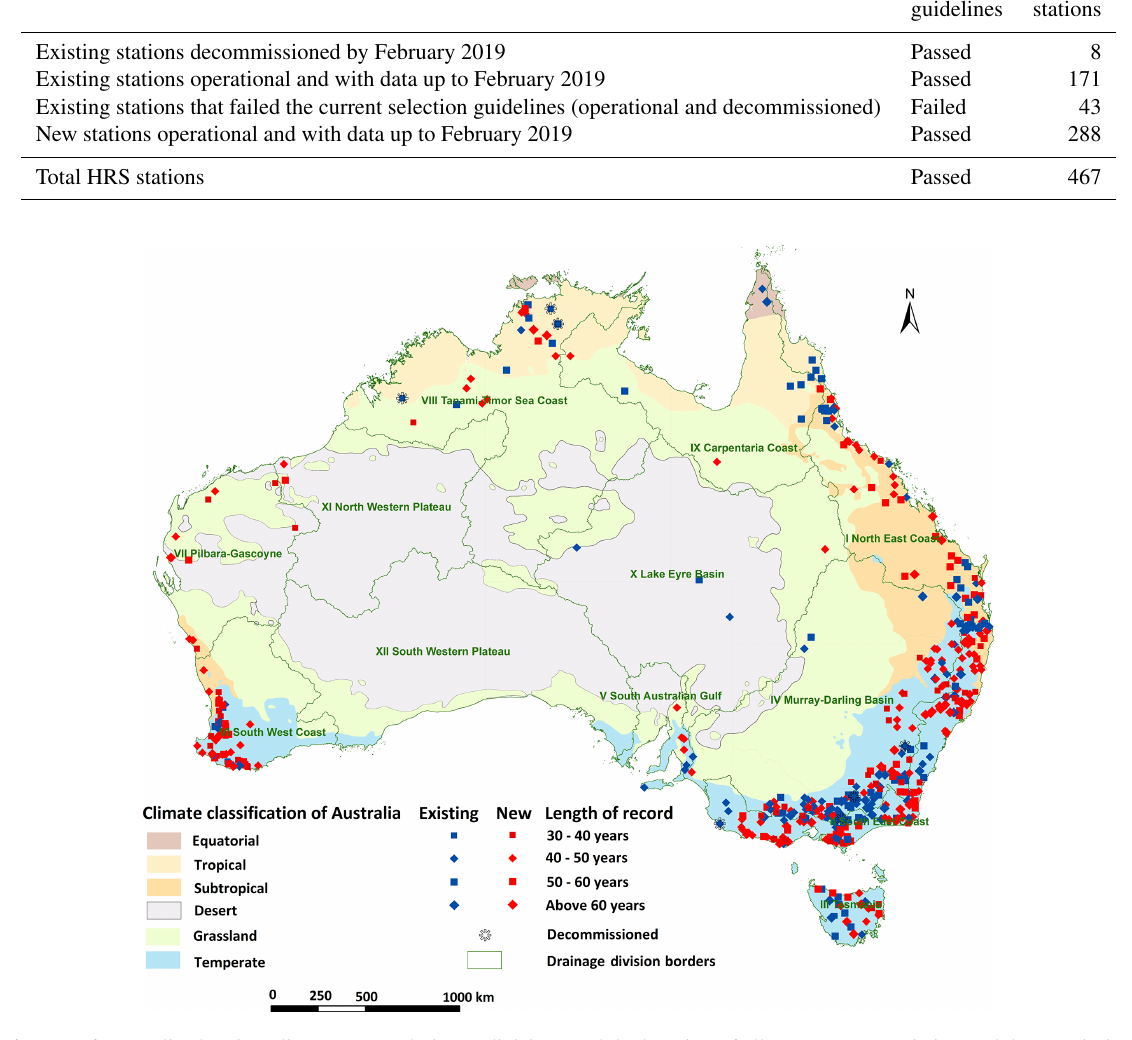
Figure 1. Map of Australia showing climate zones, drainage divisions and the location of all gauges (new, existing and decommissioned), all scaled to length of